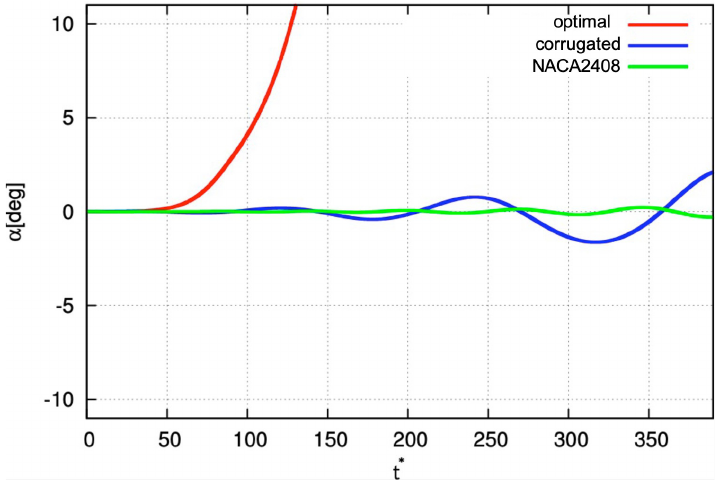
Figure 20. Time evolution of angle of attack at Re = 4000 with the initial α = 0 ◦